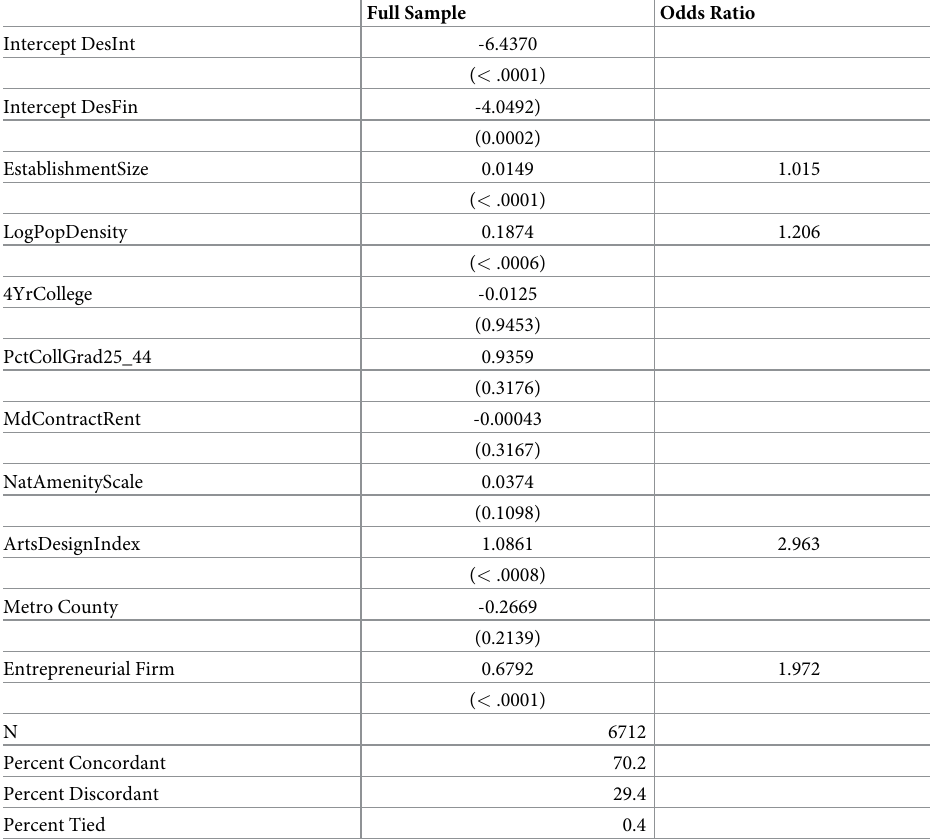
Table 2. Ordered logistic regression of design orientation for all establishments in